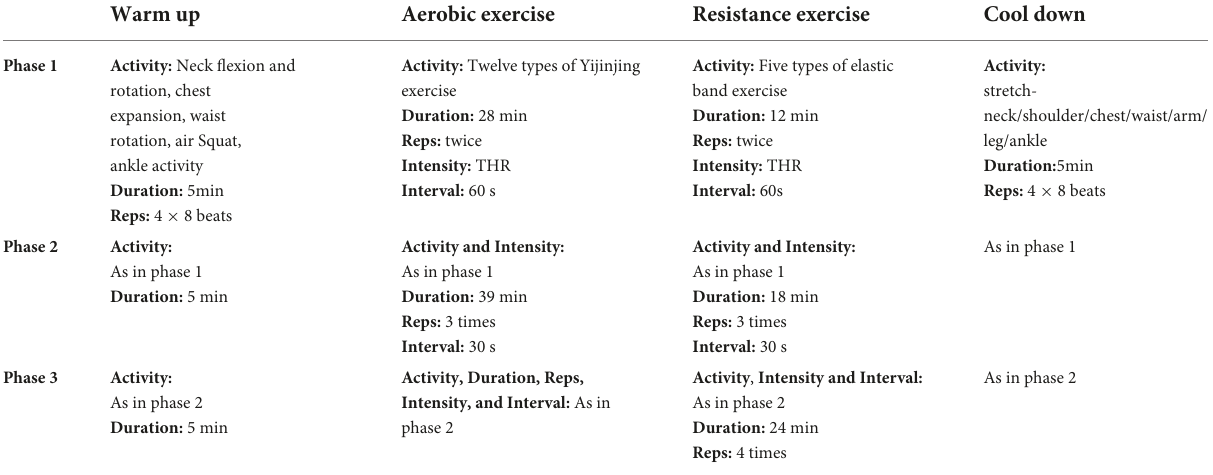
TABLE 1 Exercise intervention